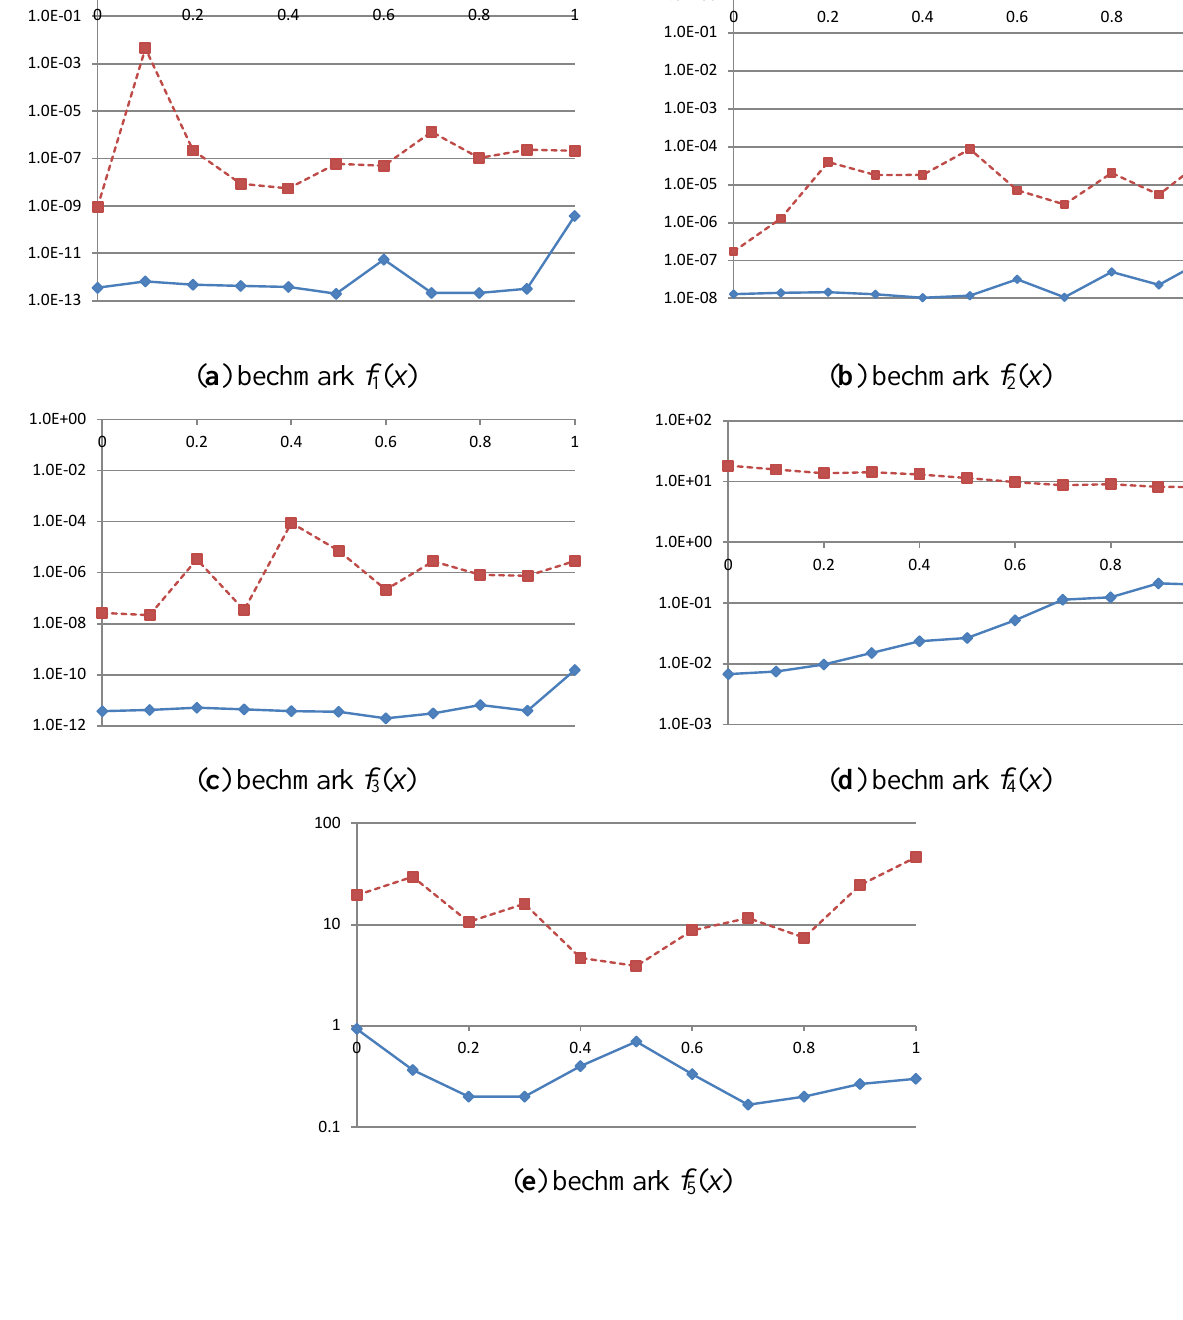
Figure 6. ICAAI (solid line) and ICACI (dashed line) for unimodal benchmark functions f ~ f . The horizontal axis is ρ, and the vertical axis is the average of the best 1 5 objective